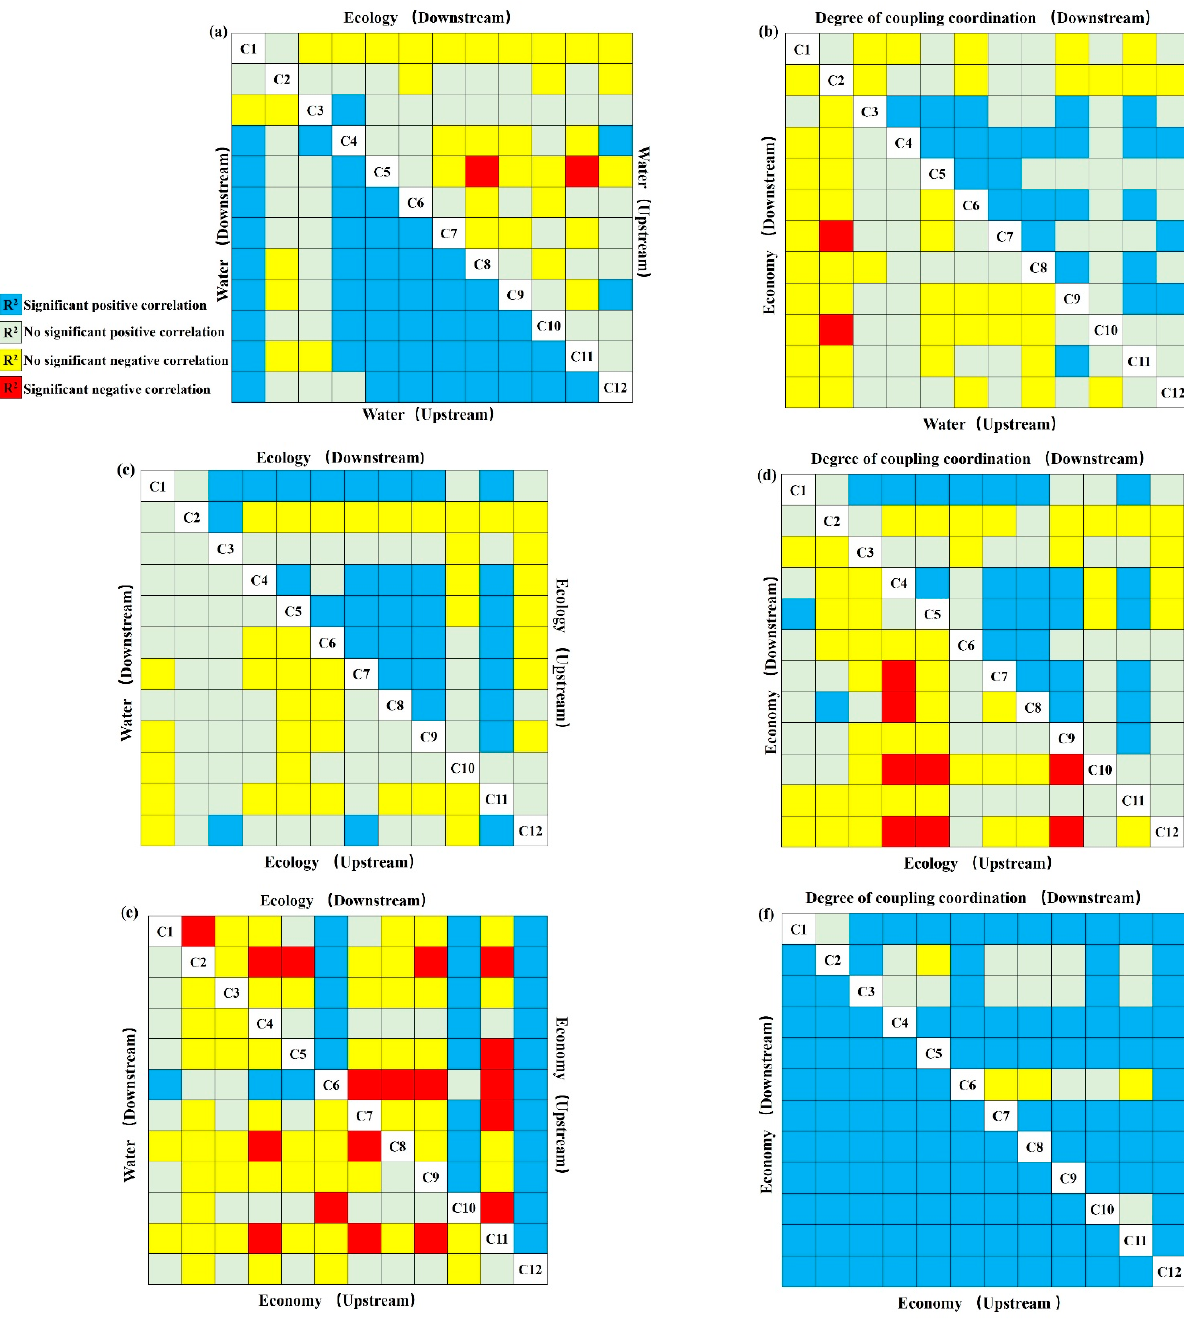
Figure 8. The cross-county patterns of the partial correlation between water, ecology, economy sub- system evaluation indices and water–ecology–economy coordinated degree in the Wuding River watershed. Subfigures show partial correlation coefficient between ( a ) upstream water and downstream water as well as upstream water and downstream ecology, ( b ) upstream water and downstream economy as well as upstream water and downstream coordinated degree, ( c ) upstream ecology and downstream water as well as upstream ecology and downstream ecology, ( d ) upstream ecology and downstream economy as well as upstream ecology and downstream coordinated degree, ( e ) upstream economy and downstream water as well as upstream economy and downstream ecology, ( f ) upstream economy and downstream economy as well as upstream economy and downstream coordinated degree. C1: Dingbian; C2: Otog Front Banner; C3: Wushen; C4: Yuyang; C5: Hengshan; C6: Jingbian; C7: Mizhi; C8: Zizhou; C9: Suide; C10: Zichang; C11: Qingjian; C12: Yan- chuan.